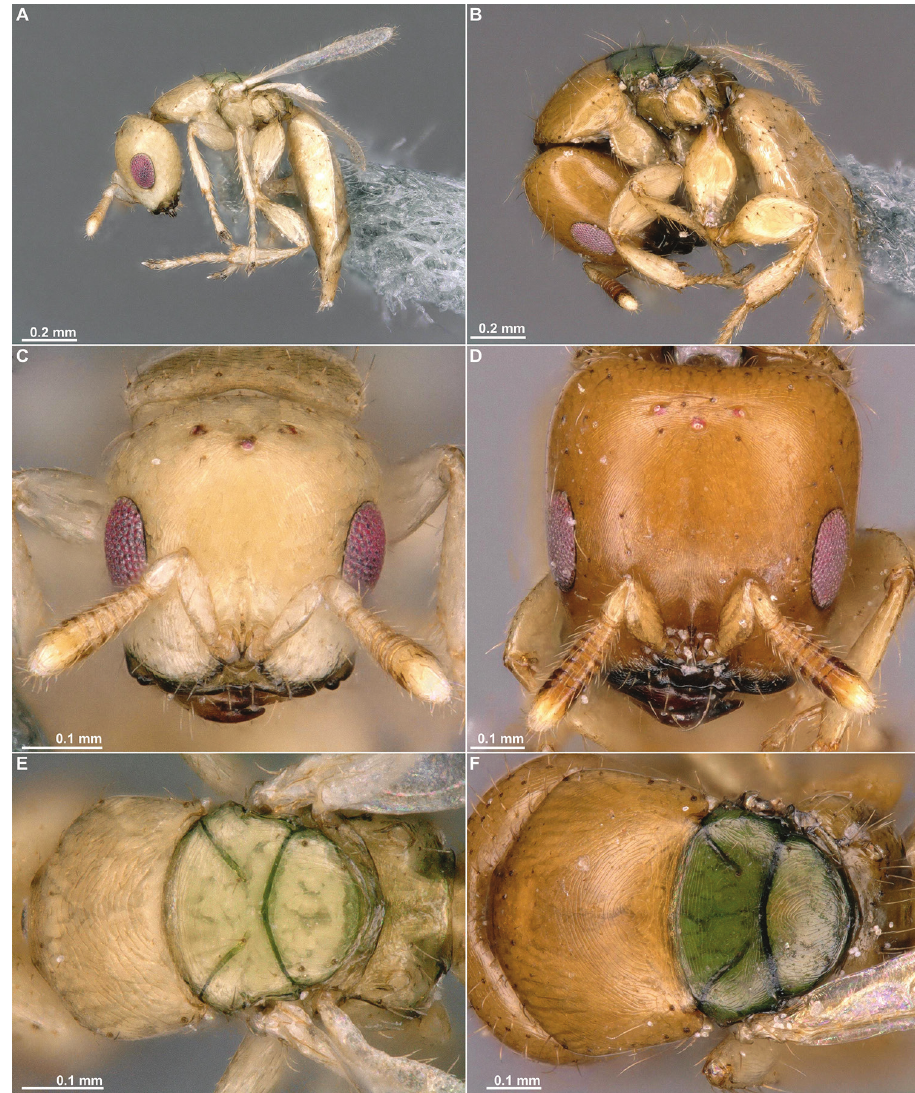
Figure 7. Sycobia hodites Farache & Rasplus, sp. n. Brachypterous males. A, C, E Small form B, D, F Large form A, B Habitus, lateral view C, D Head, frontal view E, F Mesosoma, dorsal view.